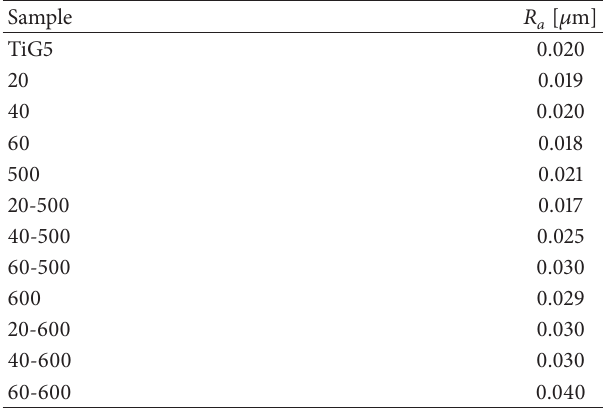
Table 2: Roughness values, 𝑅 𝑎 , of the samples.